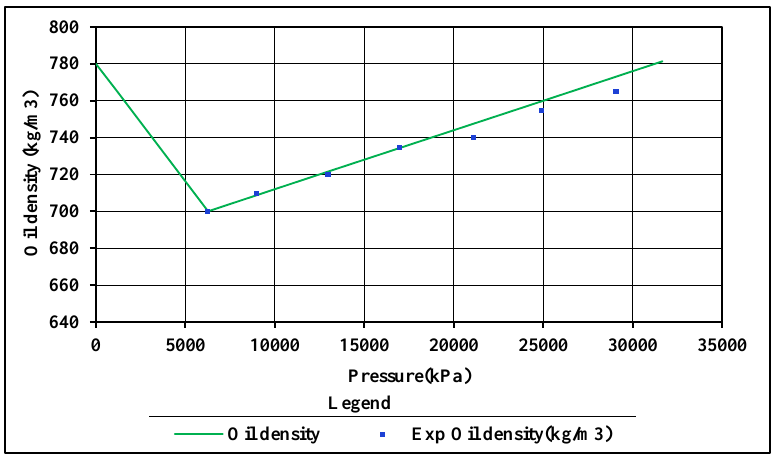
Figure 2—Fitting result of the oil viscosity at the formation temperature.